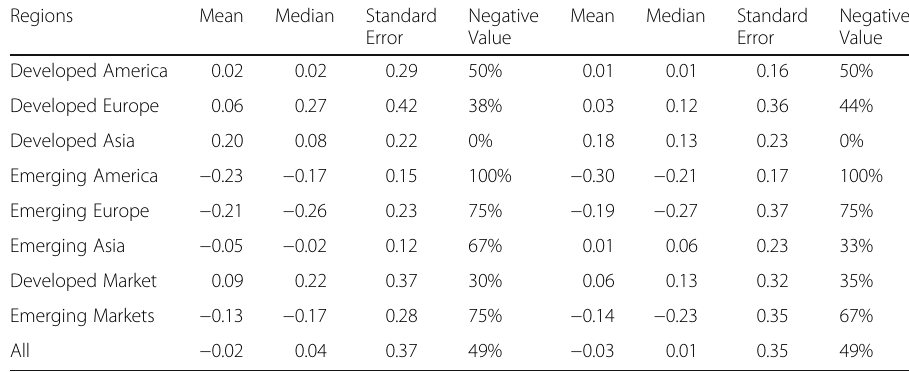
Negative Mean Median Standard Negative Error Value Error Value 0.23